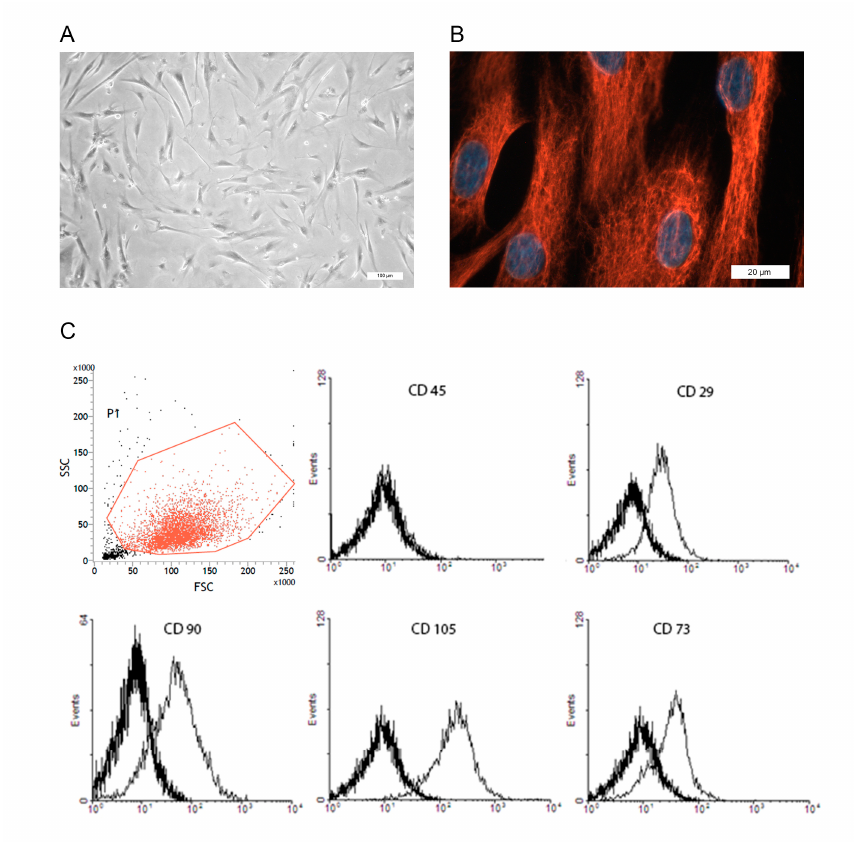
Figure 1. Characterization of human perirenal mesenchymal stromal/stem cells (prASCs) in vitro. ( A ) Characteristic phase contrast microscopy of prASCs in passage 2 (bar: 100 µm); ( B ) Immunofluorescence staining of intermediate filament vimentin, nuclei were counterstained with DAPI (bar: 20 µm); ( C ) Representative flow cytometric overlay histograms of characteristic marker expression (CD73, CD90, CD105, CD29) and of CD45, a pan leukocyte marker which is not expressed on MSCs. Thick black histograms represent isotype controls. A dot plot shows the forward and sideward scatter analysis with the gating strategy to eliminate